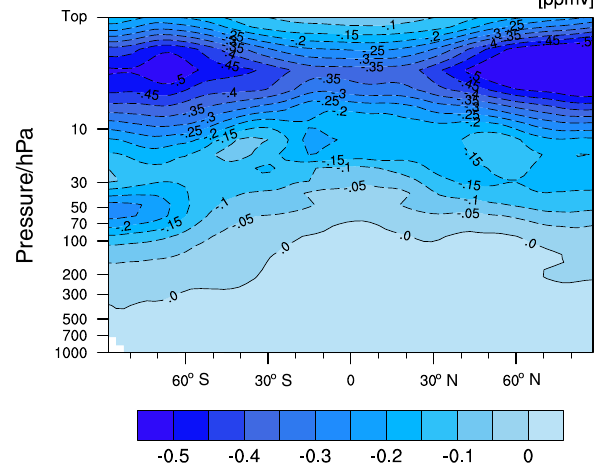
Figure 4. Zonal geographical distribution of the annual mean strato- spheric O 3 change between 1980 and